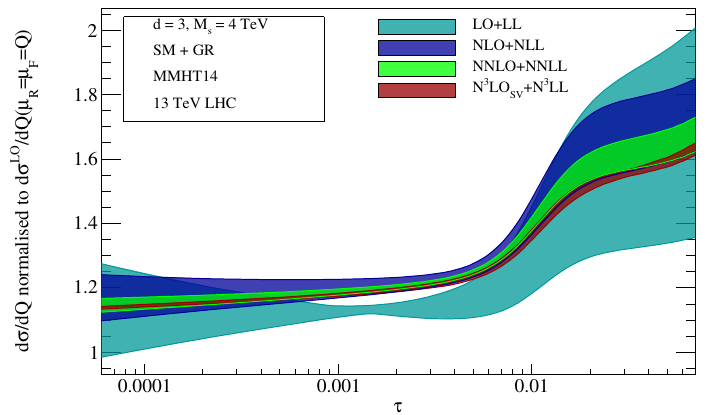
Figure 12 . Seven point scale variation of invariant mass distribution of di-lepton pair at the LHC for the signal with M S = 4 and d = 3. All the plots are normalized with LO contribution calculated at (cid:22) r = (cid:22) f = Q and corresponding PDF at di(cid:11)erent